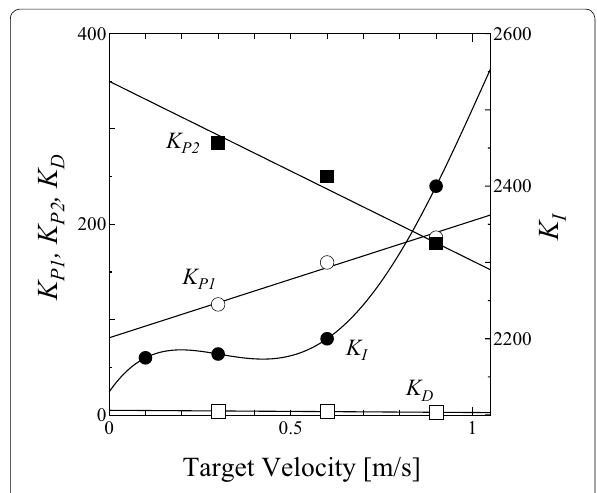
Fig. 14 Feedback gains of the isokinetic mode